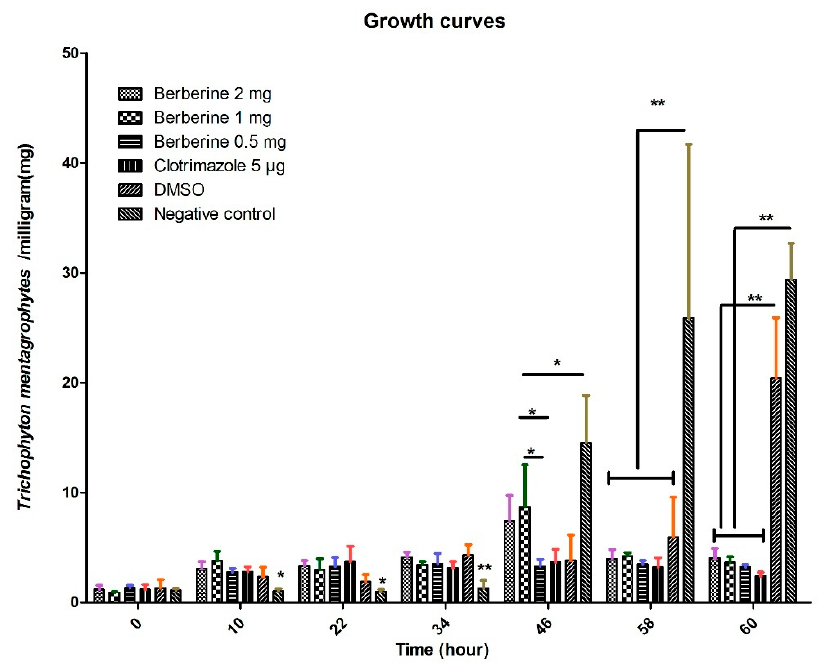
Figure 1. Growth curve by dry weight determination; Growth rates of T. mentagrophytes treated with berberine hydrochloride (0.5, 1, and 2 mg/mL) or clotrimazole (5.0 µ g/mL). After 60 h, the growth rate of T. mentagrophytes treated with control was significantly higher than those of the berberine hydrochloride or clotrimazole groups, but was not significantly different from DMSO treated fungi. * and ** stand for p < 0.05 and p < 0.01 respectively.